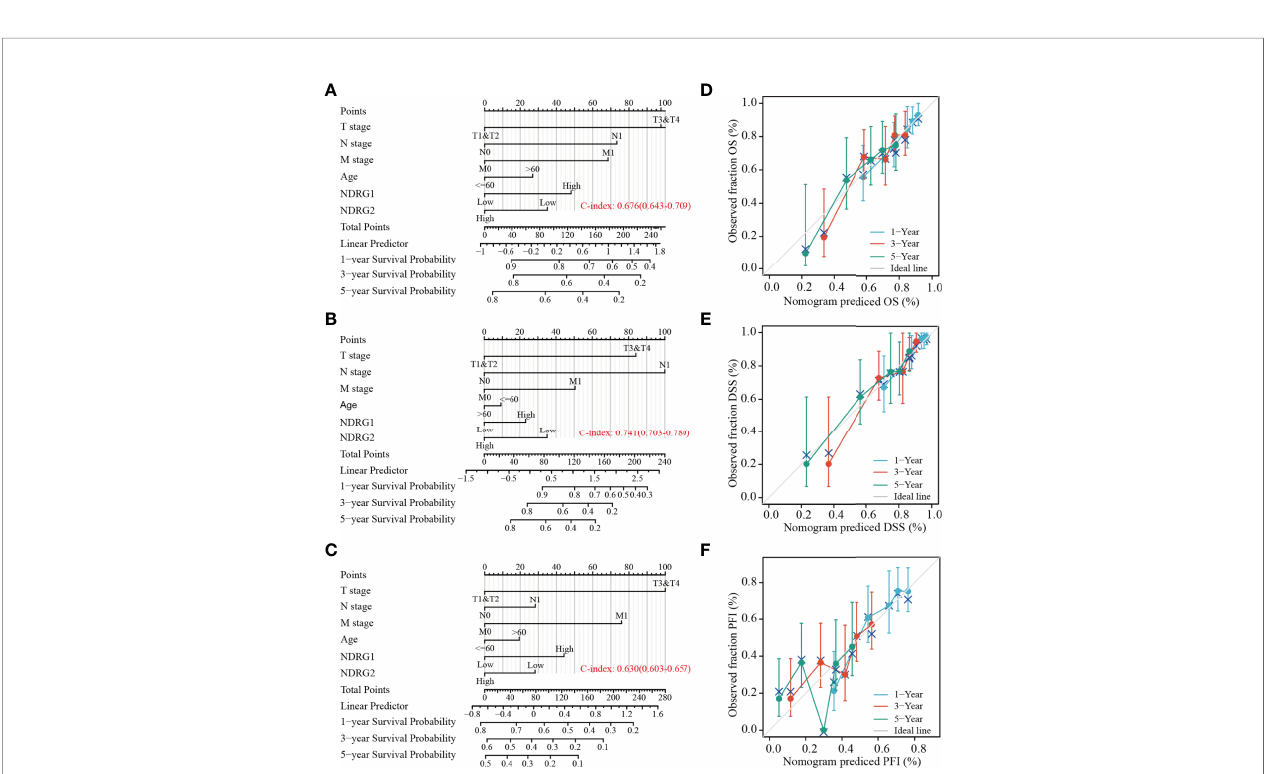
FIGURE 7 | Construction and calibration of nomograms based on NDRG1 or NDRG2 expression. (A – C) Risk scoring models for 1-, 3-, and 5-year overall survival (OS), disease-speci fi c survival (DSS), and progression-free interval (PFI). (D – F) Calibration diagrams validating the ef fi ciency of nomograms for OS, DSS, and